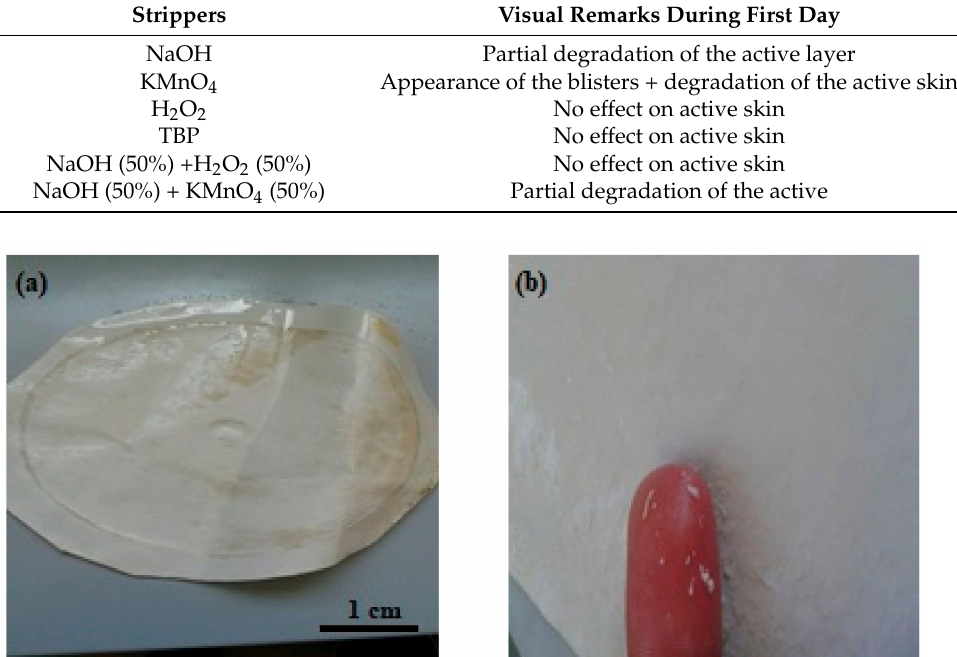
Figure 4. Photos of spent RO membrane ( a ) after treatment with NaOH and ( b ) degradation of active